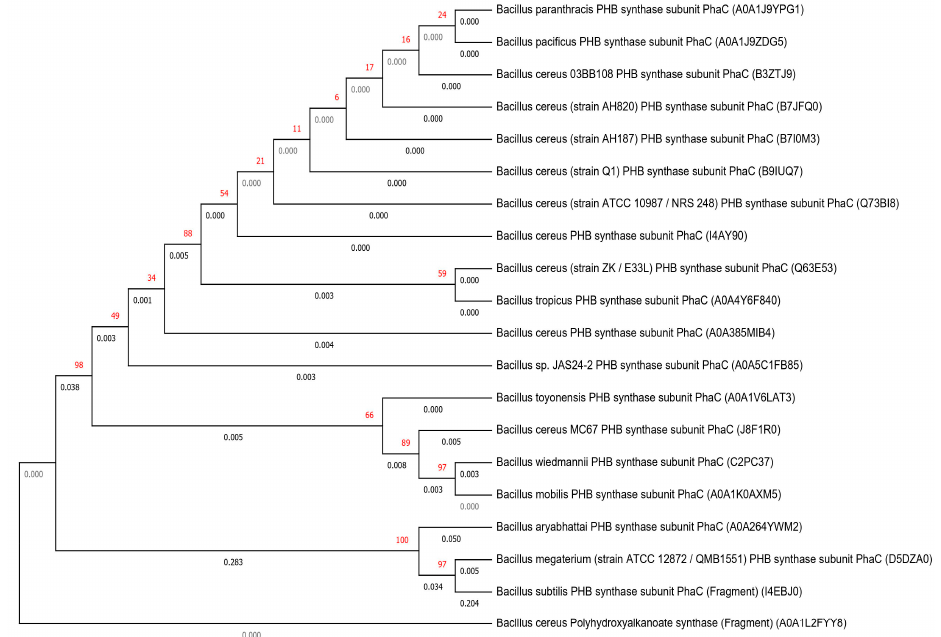
Figure 1. Taxonomic interrelationship among the different Bacillus species—phylogenetic tree constructed using the neighbor-joining method based on PhaC gene found in different Bacillus species sequenced on Uniprot database.